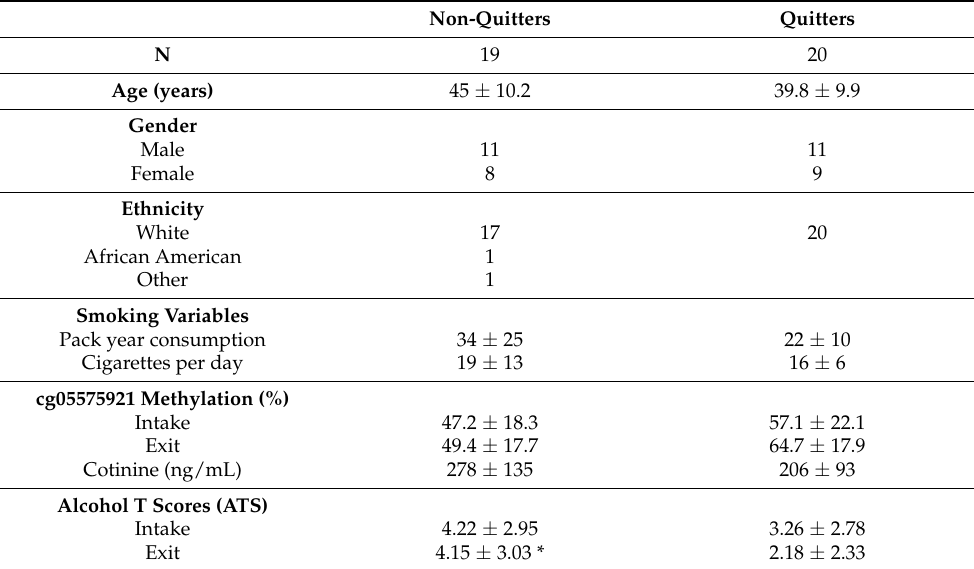
Table 1. Demographic and clinical characteristics of the